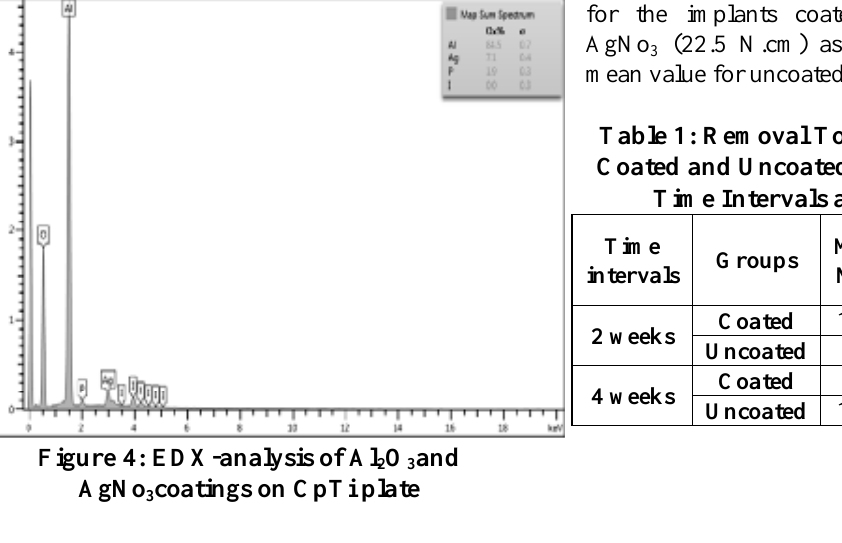
Also in table 1 descriptive removal torque